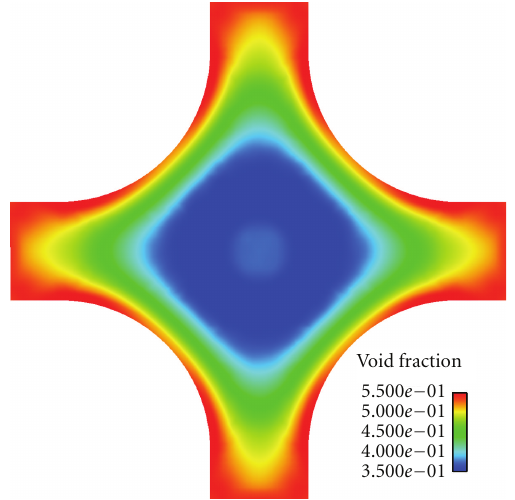
Figure 18: Void-fraction distribution at the measuring section for run 1.4325 by using the Ruyer-Seiler